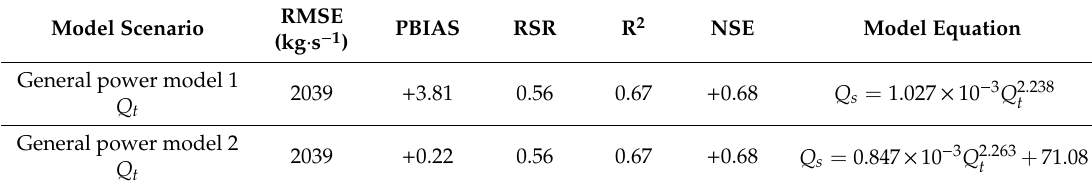
Table 4. General power